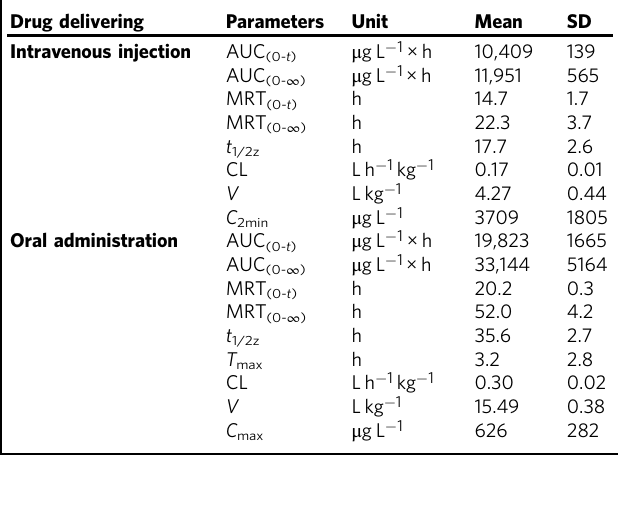
Table 2 Results of pharmacokinetic parameters of TB47 in BALB/c mice Drug delivering